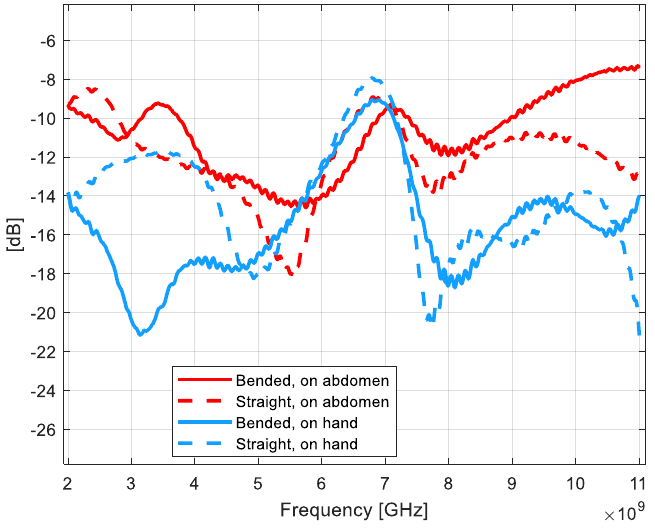
Figure 9. Impact of the bending of the antenna, measured on the abdomen (blue curves) and on the hand (red curves).